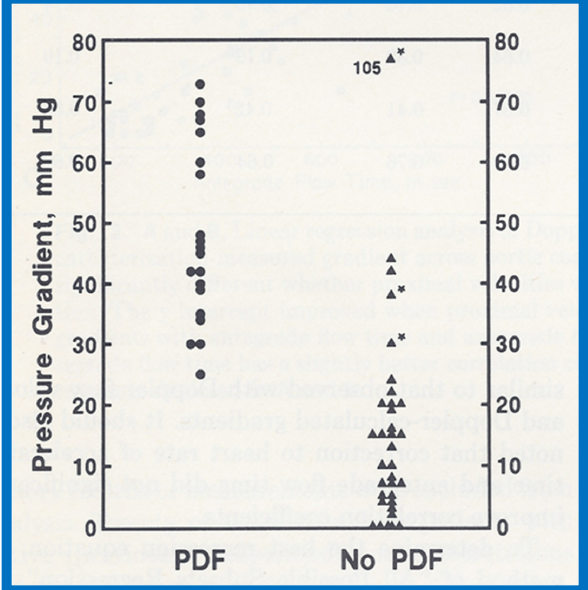
Figure 58. Catheterization ‐ measured peak ‐ to ‐ peak gradients across aortic coarctation is expressed as a function of descending aortic pandiastolic flow (PDF) distal to the coarctation site. All patients with PDF (filled circles) had gradients of 25 mmHg or more. All but five patients without PDF (filled triangles) had gradients less the 25 mmHg. Three (marked with asterisk) of these five patients had long segment coarctations. Reproduced from Rao P.S., Carey P. [18].